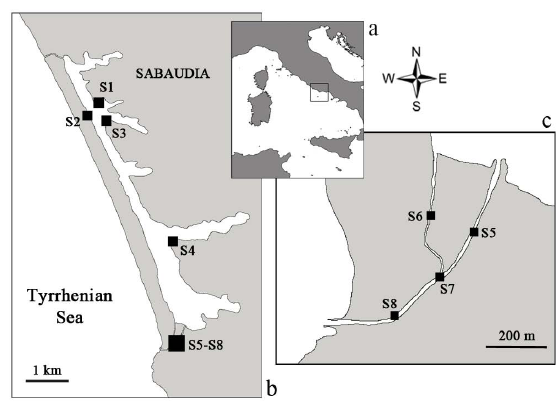
Fig. 1. Study area. A. Location of Sabaudia Lake (Italy, Tyrrhenian Sea) in the Mediterranean Sea. B-C. Sabaudia Lake. Map of the sampling sites: numbers as in Table